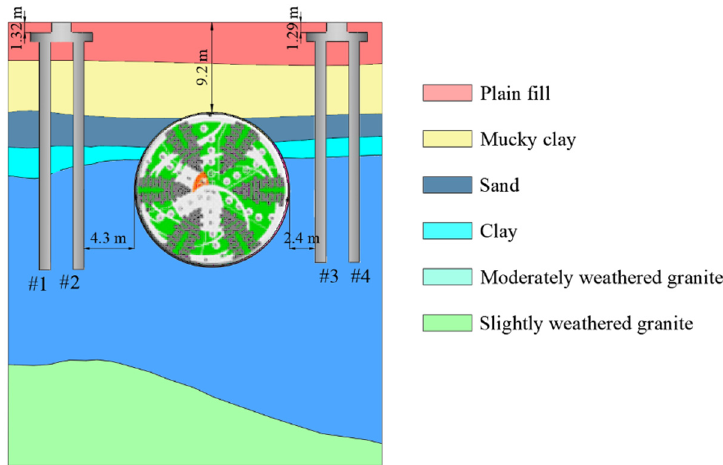
Figure 5. Relative relationship between shield tunnel and bridge piles.